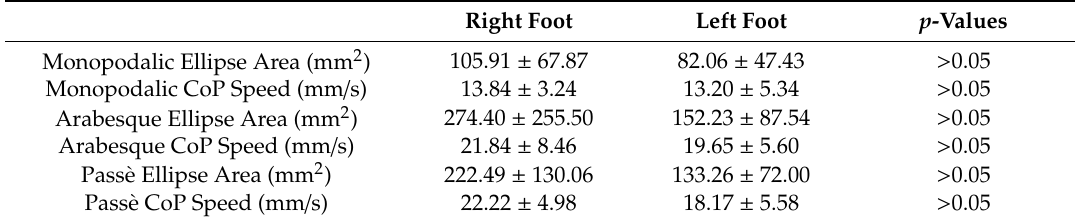
Table 2. Comparison between right and left foot in healthy subjects (N = 11) for stabilometric parameters acquired with open eyes.